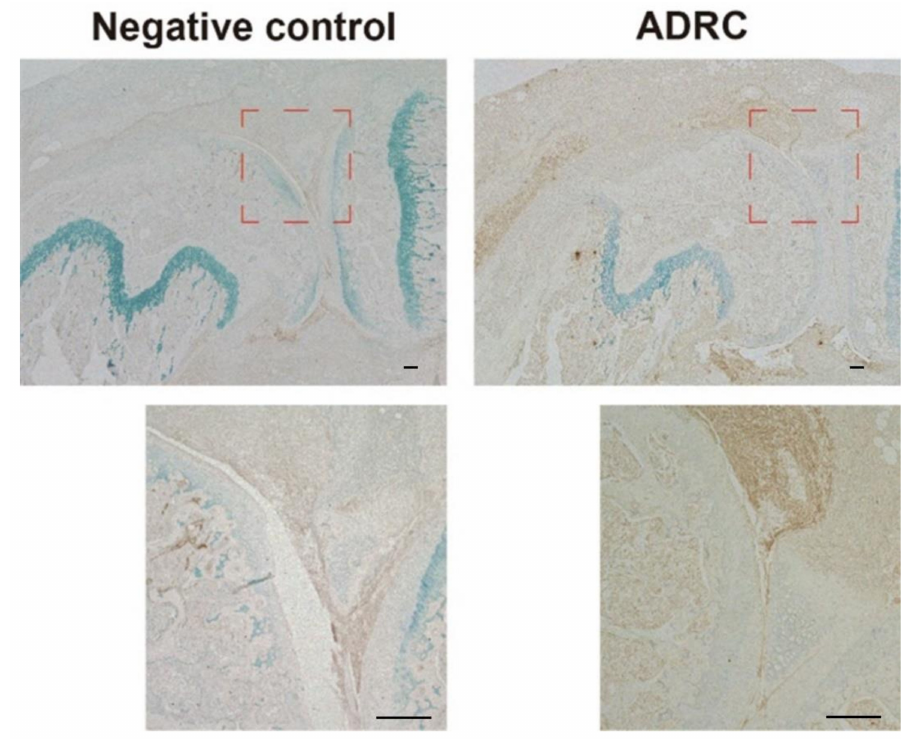
Figure 4. Immunohistochemical analyses of human nuclear antigen one week after transplantation. Representative images are shown. Lower panel show the magnified images correspond to the square area on the upper images. Scale bars = 100 µ